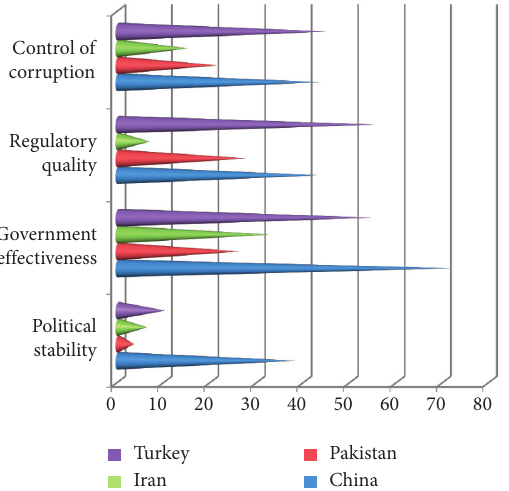
Figure 4: The political risks of four countries in 2019. Source: Kaufmann D.A. Kraay and Mastruzzi, the Worldwide Governance Indicators.